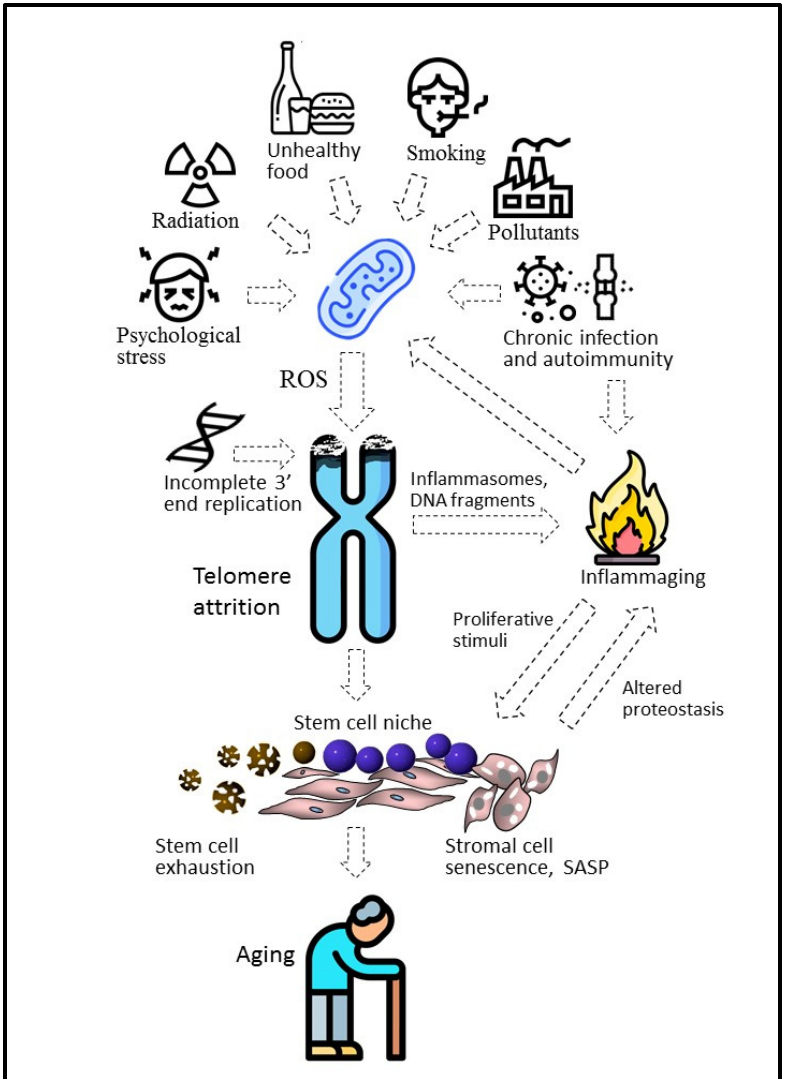
Figure 3. Telomere theory of aging; state of the art.